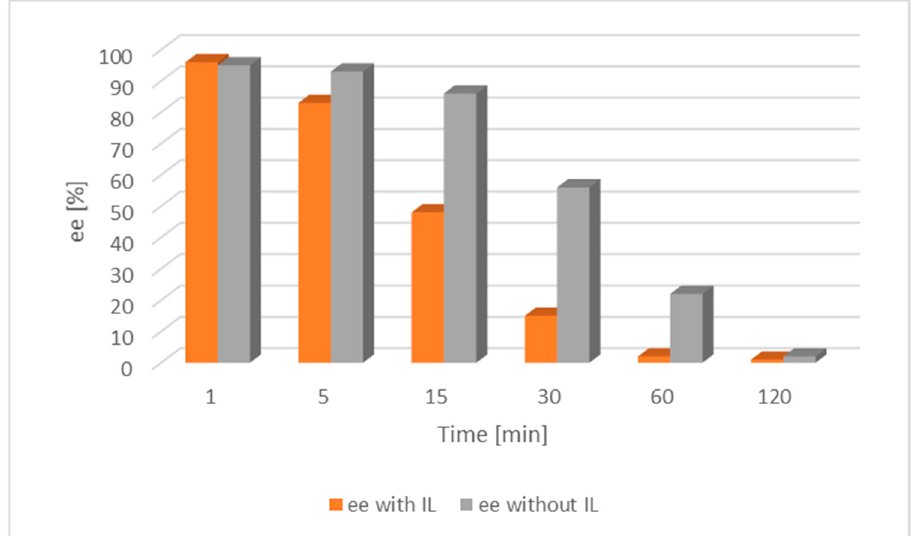
Figure 4. Comparison of the catalytic activity of [Ru(1)] with and without an IL for alcohol 1. [Ru(1)]